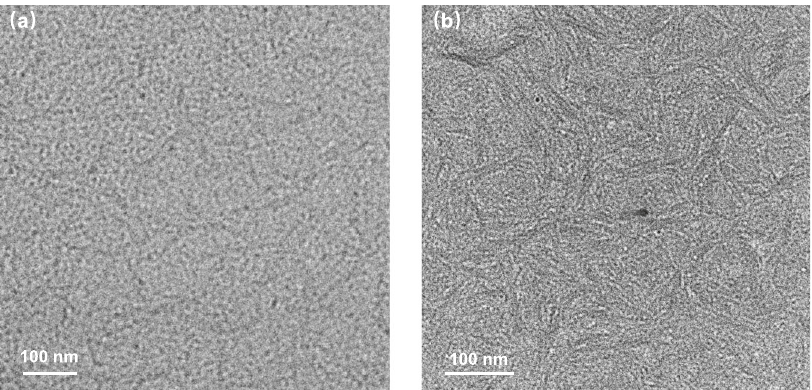
Fig. 3 Cryo-TEM images. a Cryo-TEM images of the frozen PBDB-T:PN-Se blend precursor solution in chloroform. b Cryo-TEM images of the frozen PBDB- T:PS-Se blend precursor solution in chloroform.